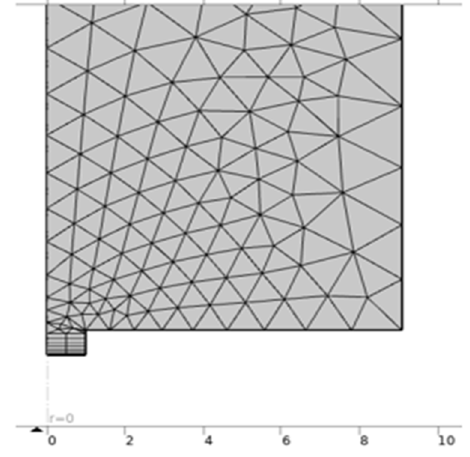
Figure 5. Dividing the working area of the model into a finite element mesh.